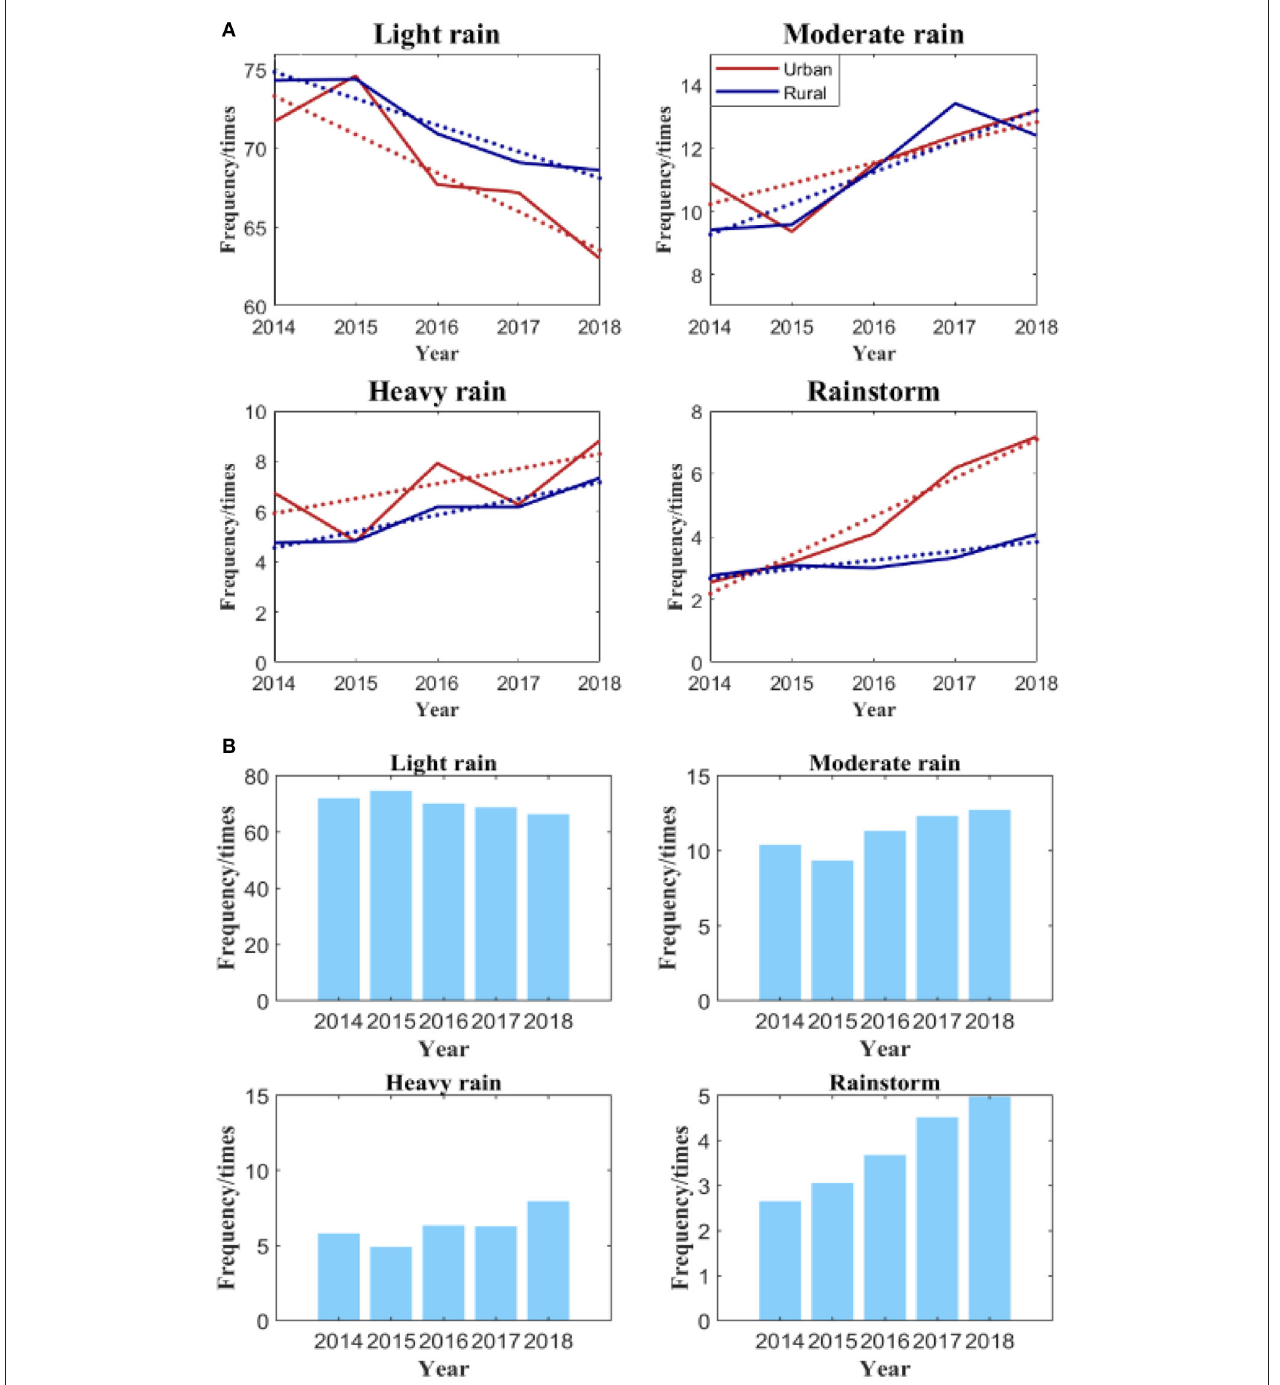
FIGURE 9 | (A) Line (dashed lines indicate corresponding linear trends) and (B) Bar graphs of occurrence frequency of precipitation classes in Guangdong, 2014–2018.